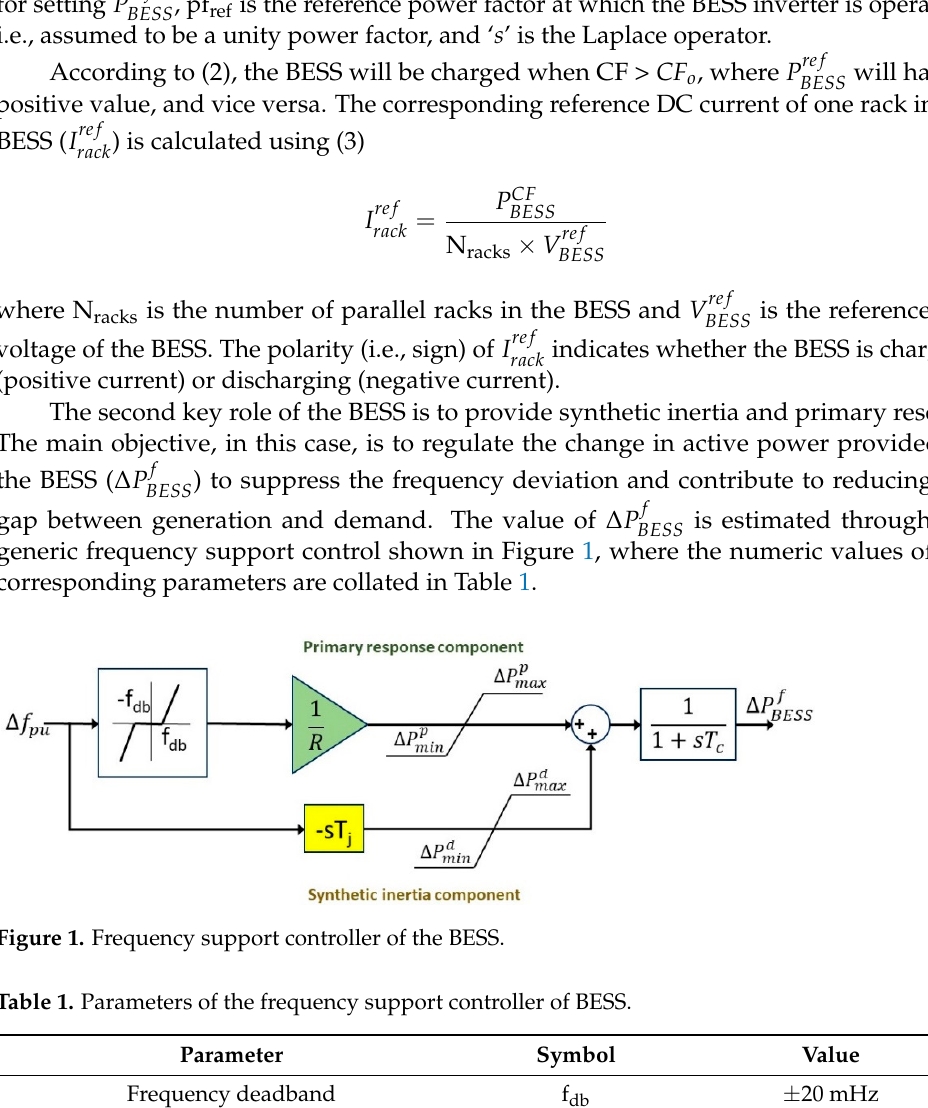
Table 1. Parameters of the frequency support controller of BESS.